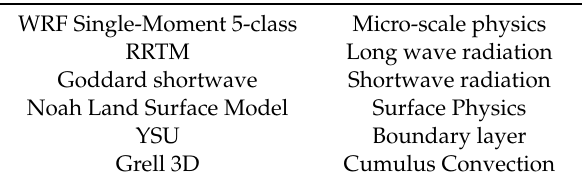
Table 3. Lists the parameterization schemes used to implement the Weather Research and Forecasting model with chemistry (WRF-Chem)